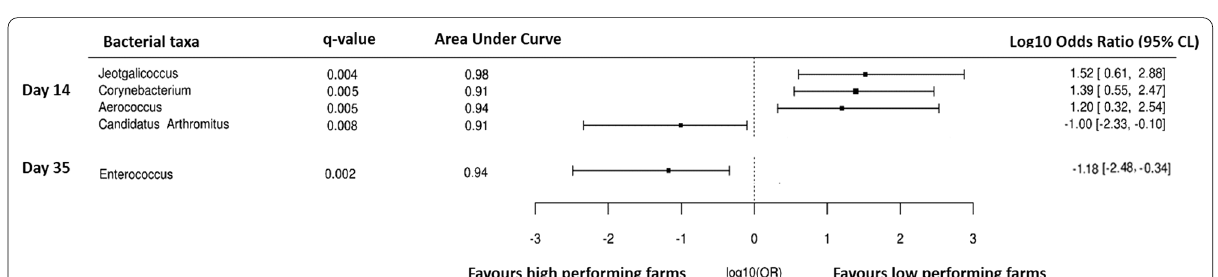
Fig. 9 Forest plot of the significantly different bacterial taxa (Wilcoxon q value < 0.05) of company B farms in excreta with AUC to the left of the vertical line (line of no effect) denotes the increased chance of occurrence of microbiota towards high‑performing farm and the results to the right of the vertical dotted lines denotes the increased chance of occurrence of microbiota towards the low‑performing